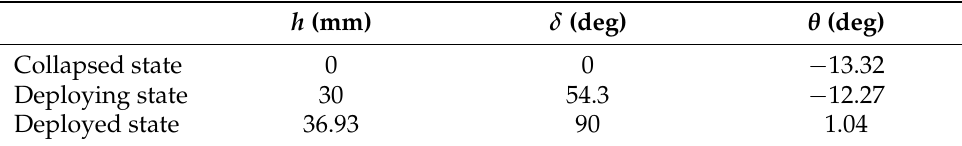
Table 3. Data from single link kinematics simulation.